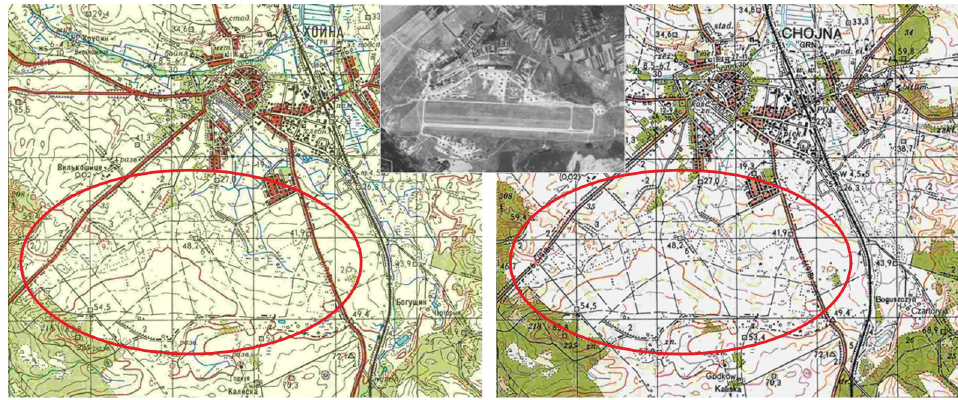
Fig. 12. Camouflaged airfield in Chojna: on the left – the Soviet map 1:50,000 (1972), on the right – the Polish map 1:50,000 (1986) and an aerial image from 1969 with visible airfield infrastructure